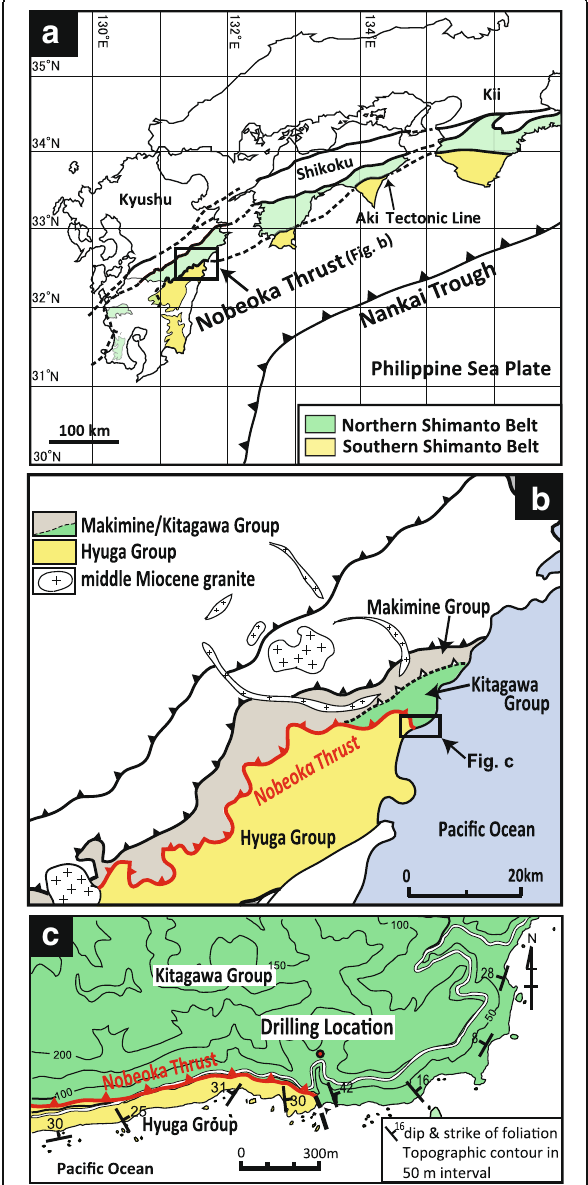
Fig. 1 Geologic setting of the Nobeoka Thrust. a Geologic setting of the Nobeoka Thrust and distribution of the Shimanto Belt in southwest Japan. b A simplified geologic map of the Shimanto Belt in northeast Kyushu, modified from Murata (1998). c Geologic map of the studied area and the locality of the drilling site (dot) for the hanging wall of the Nobeoka Thrust (modified from Kondo et al. 2005; Kimura et al. 2013; Hamahashi et al.